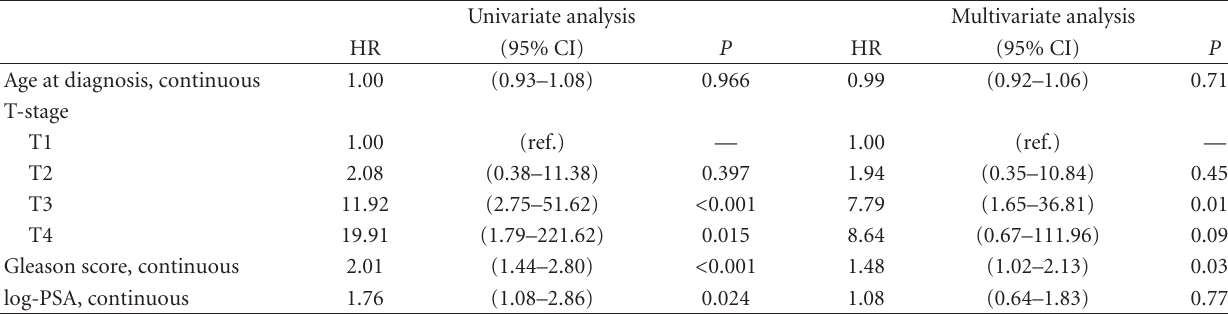
Table 3: Cox regression model—distant